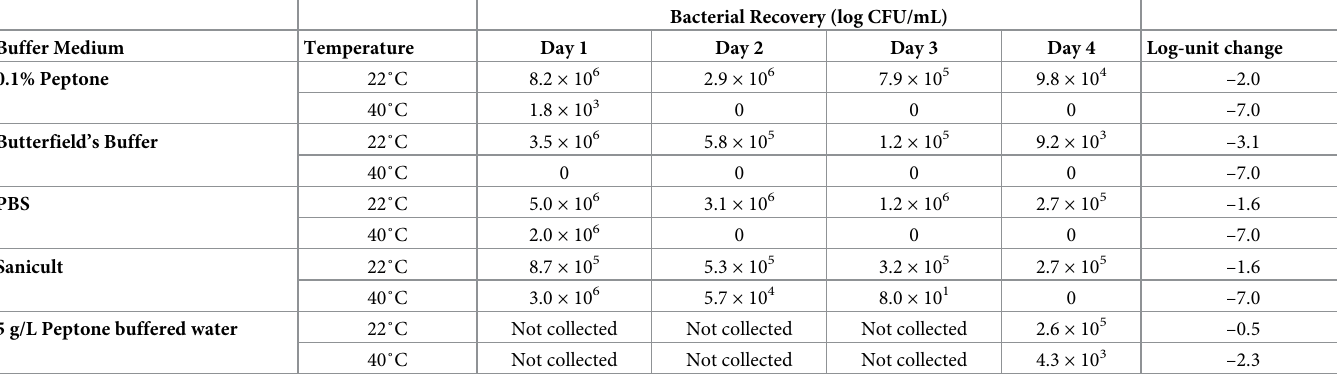
Table 2. Maintenance of F . novicida U112 viability in commercial buffers at two